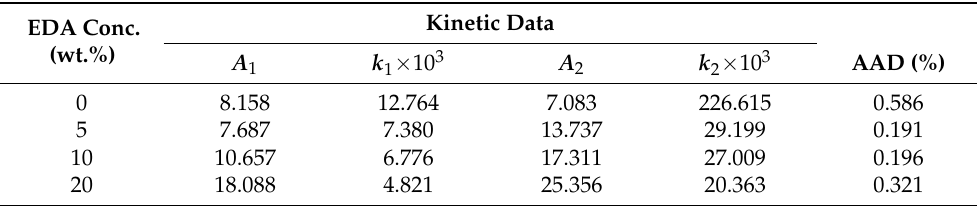
Table 3. CO 2 capture using EDA: Kinetic model parameters for Equation